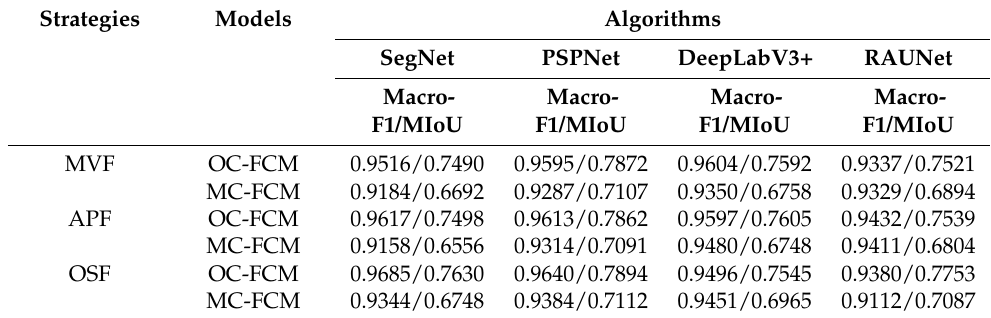
Table 5. Accuracy differences between OC-FCM and MC-FCM based on different CNN algorithms. Strategies Models Algorithms SegNet PSPNet DeepLabV3+